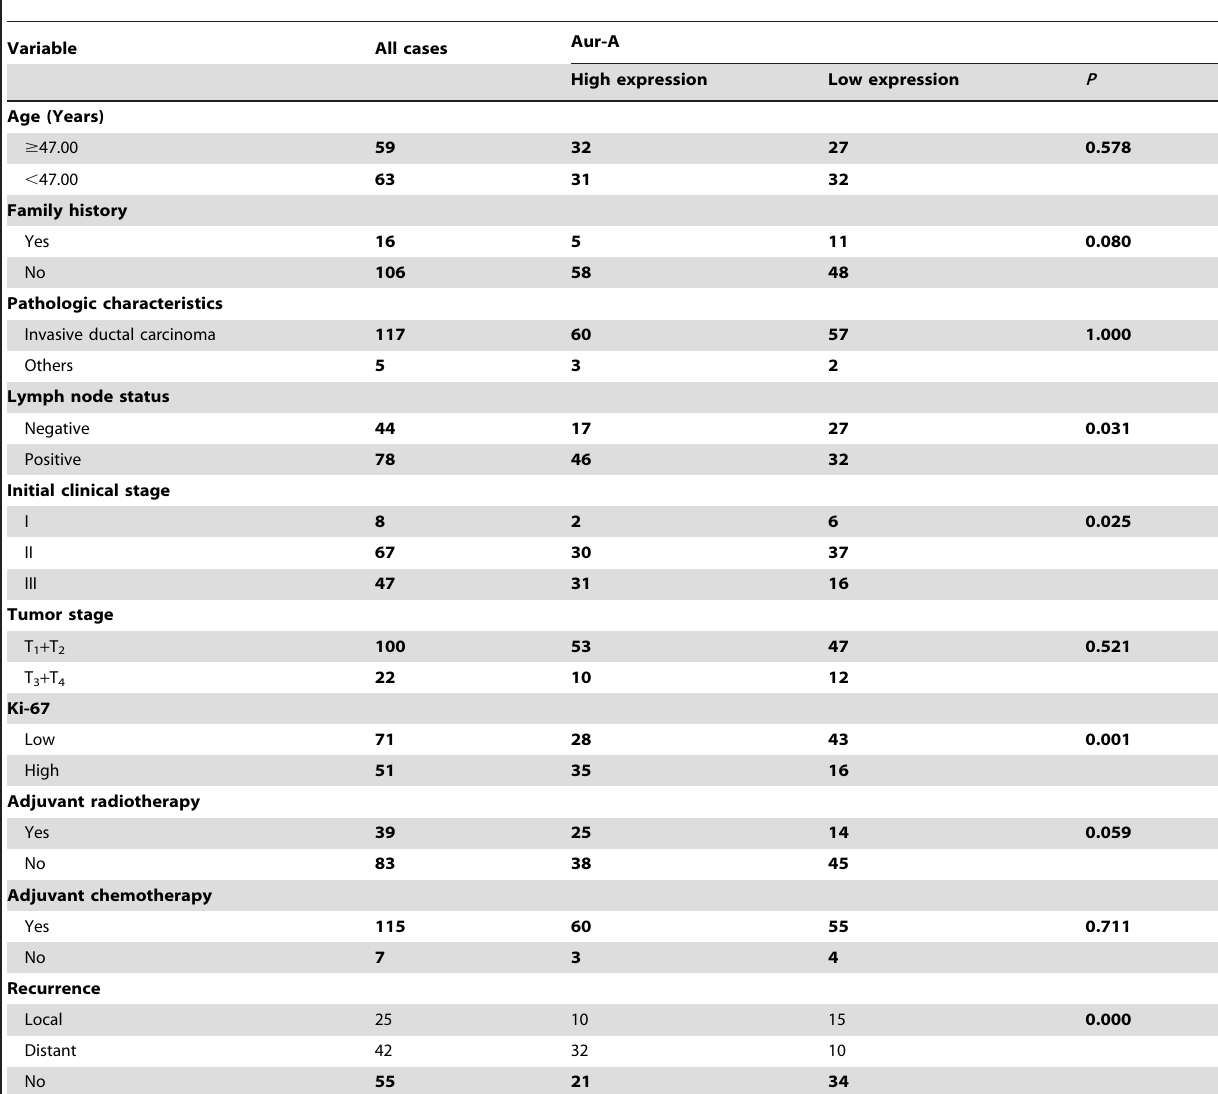
Table 1. Association of Aur-A expression with patient’s clinicopathologic characteristics in TNBC